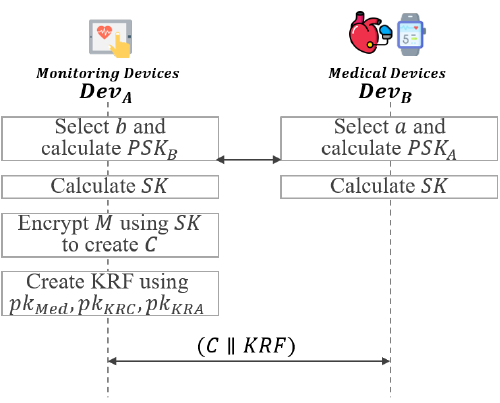
Figure 10. Session key exchange and KRF generation phase of proposed scheme-II.